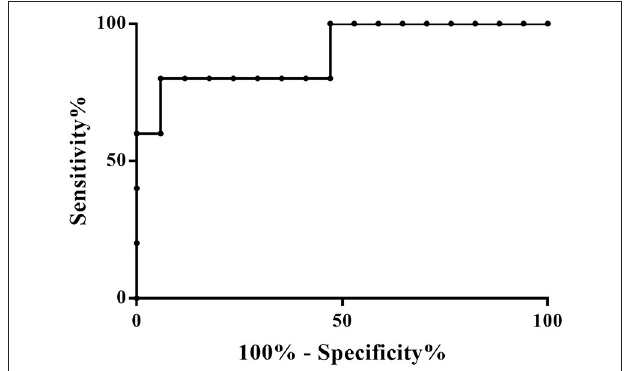
FIGURE 5 | Representative ROC curves based on metabolites with p -value < 0.01 between ≤ 30w No-hsPDA and ≤ 30w hsPDA subjects. AUC: 0.894; Standard Error: 0.09; 95% CI: 0.717–1; p -value: